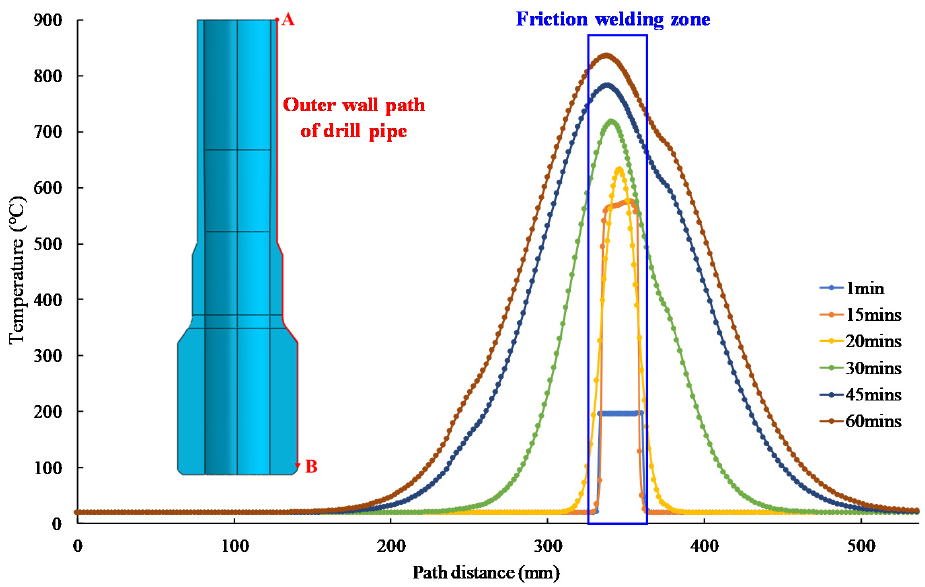
Figure 12. Temperature variation curves at different times along the outer path of drill